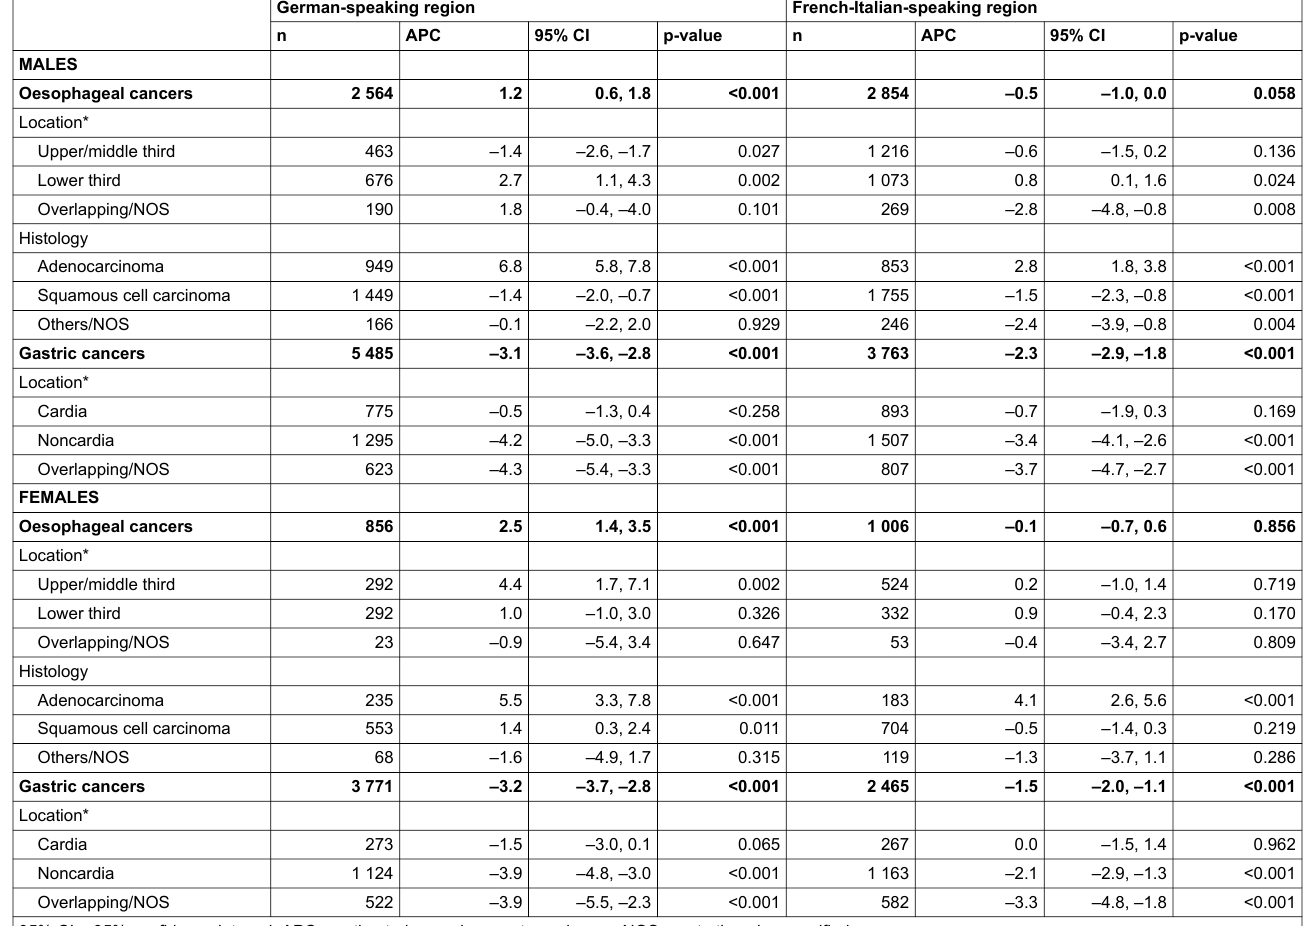
Table 2: Estimated annual percentage change for oesophageal and gastric cancer by sex, histology, anatomical location and language region from 1982 to